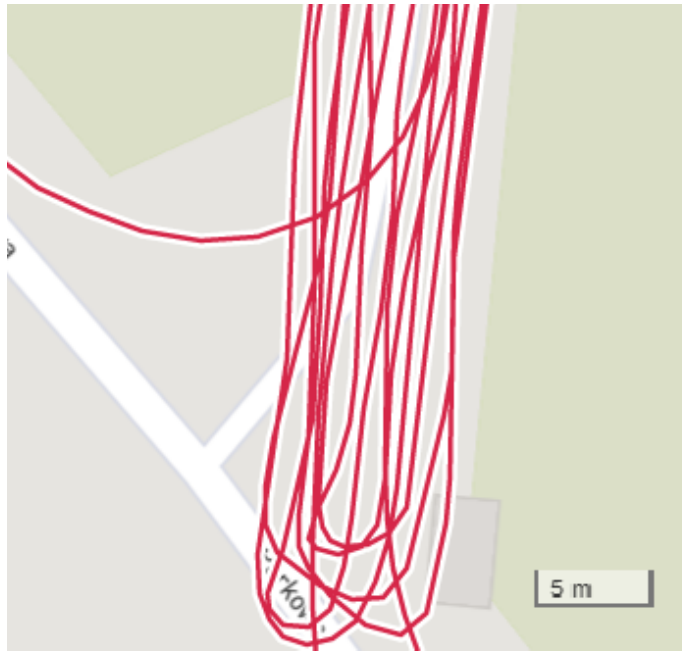
Figure 11. Turning around test with proposed system (Samsung phone).